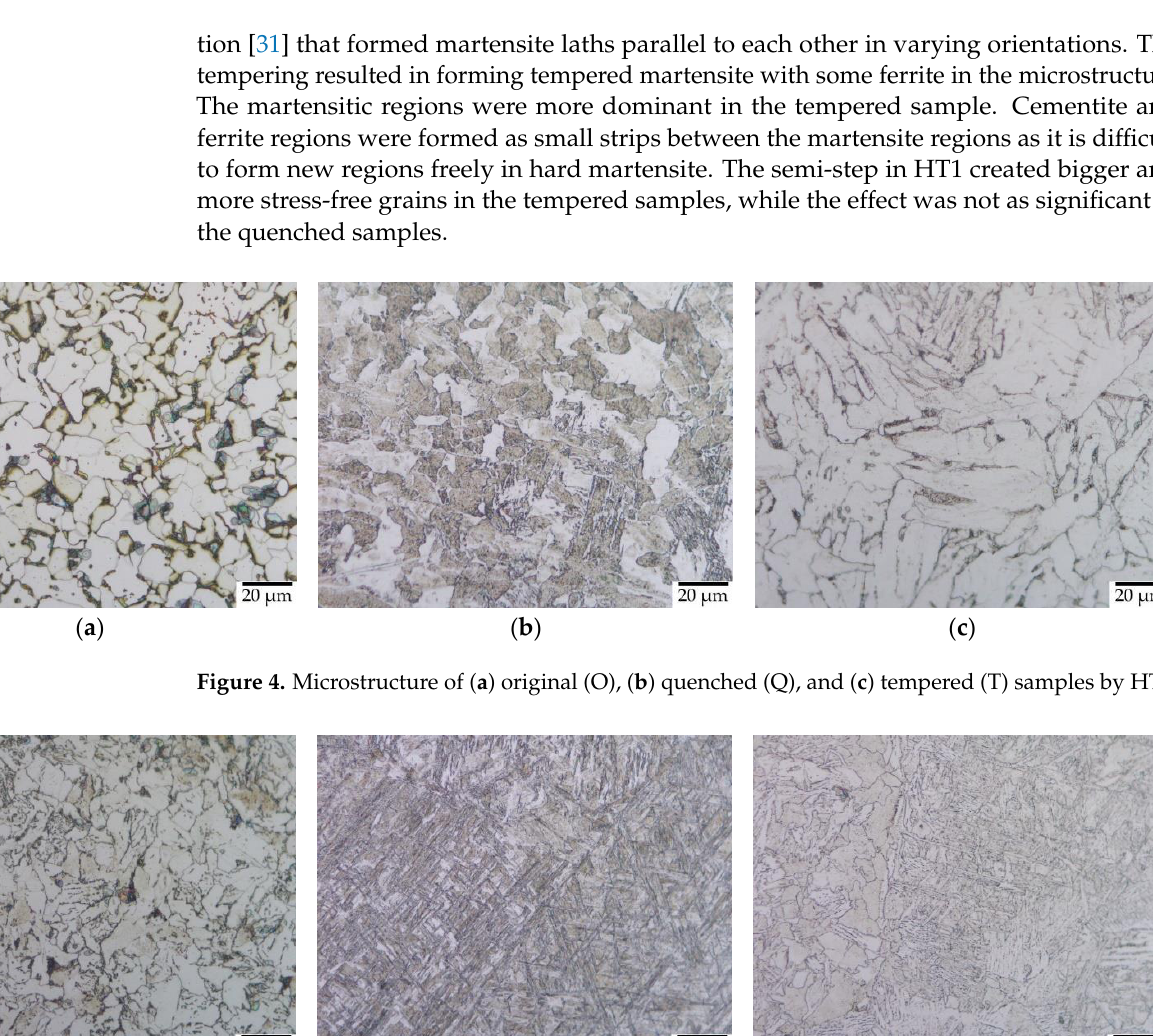
Figure 5. Microstructure of ( a ) original (O), ( b ) quenched (Q), and ( c ) tempered (T) samples by HT2.